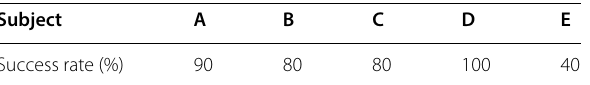
Table 2 Success rate of voice commands (five subjects, ten trials for each subject)